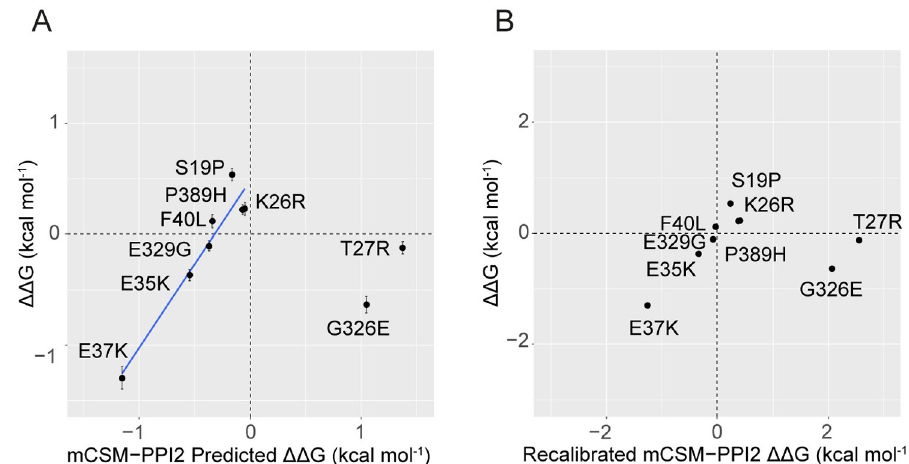
Fig 4. A. mCSM-PPI2 predicted ΔΔ G is linearly correlated with SPR determined ACE2 variant Spike RBD affinities for ACE2 variants with negative predicted ΔΔ G. The linear model shown was fit to the eight ACE2 mutants with predicted ΔΔ G < 0 kcal mol -1 (slope = 1.56, intercept = 0.52, R 2 = 0.91, p = 0.0006, n = 7). As explained in the text, p.Thr27Arg and p.Gly326Glu were excluded from the fit because the SPR data show that the mCSM-PPI2 prediction for these variants is incorrect, in keeping with the poorer performance of affinity predictions involving higher ΔΔ G [23]. The recalibration is thus strictly applicable only to predicted ΔΔ G within the range of interpolation. p.Asp355Asn is also not included because in our SPR experiments this ACE2 mutant could not be detected binding to RBD and so we do not have an exact experimental affinity for this mutant; inclusion of this variant’s estimated maximum ΔΔ